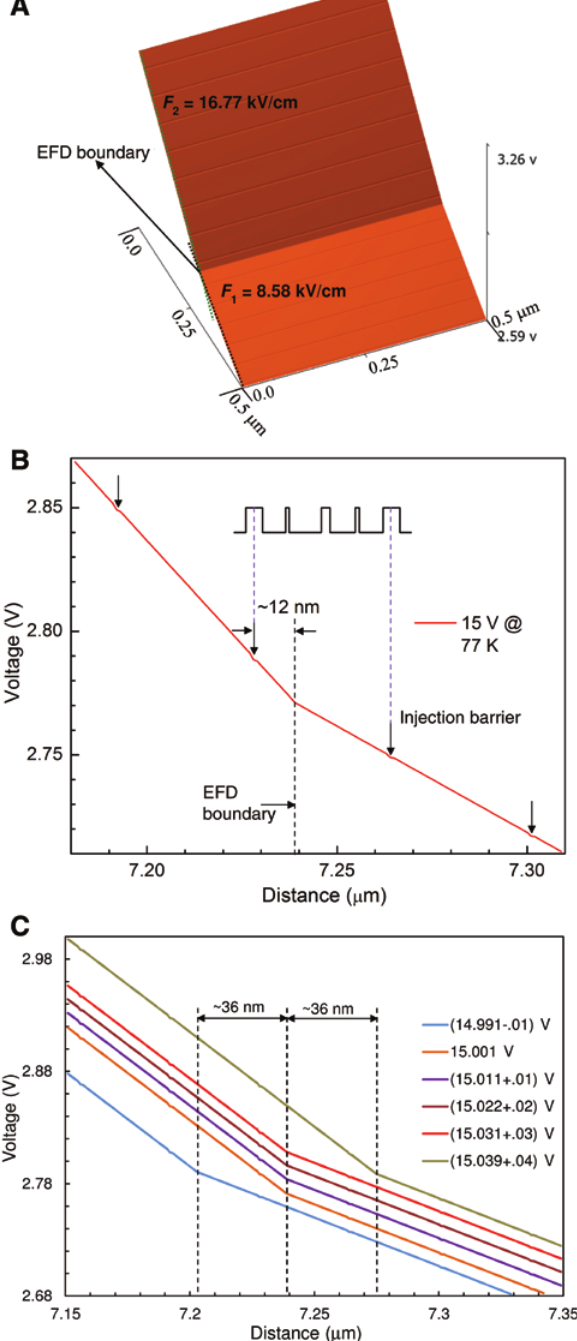
Figure 19: High-resolution SVM scans near the boundary of EFDs. (A) The 2D SVM voltage image over a 512 × 512 nm 2 scan area at 15 V and 77 K. (B) A 1D zoomed-in voltage curve over three modules in a row, showing the exact location of the EFD boundary (the turning point of the electric field). (C) 1D SVM voltage profile curves at a series of device biases from 14.991 to 15.039 V, showing the hopping behavior of the EFD boundary. All curves (except the one at 15.001 V) are accumulatively shifted by 0.01 V vertically for clarity.